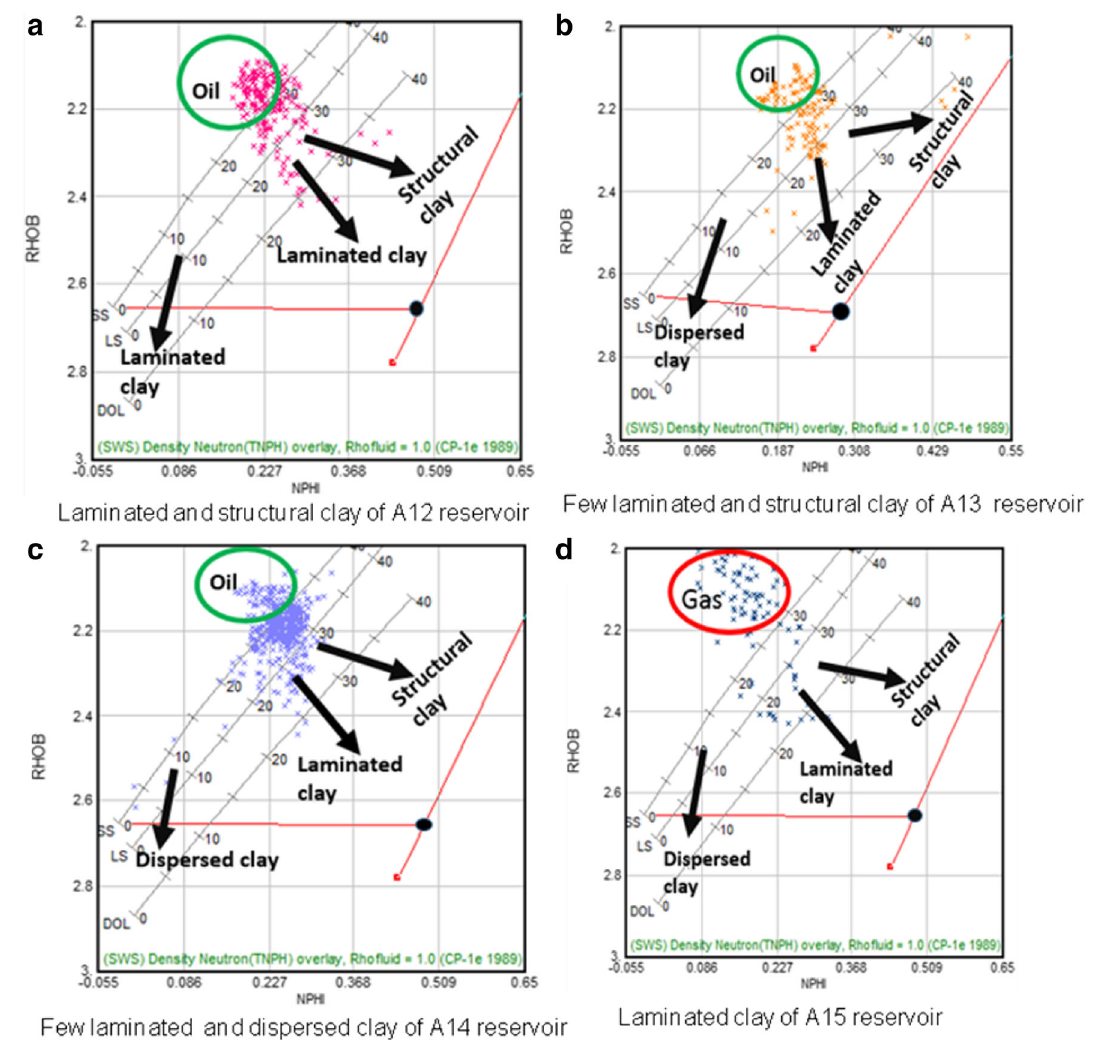
Fig. 12 Neutron–density model showing the clay distributions in the reservoirs a A12, b A13, c A14 and d A15 of JAP-4